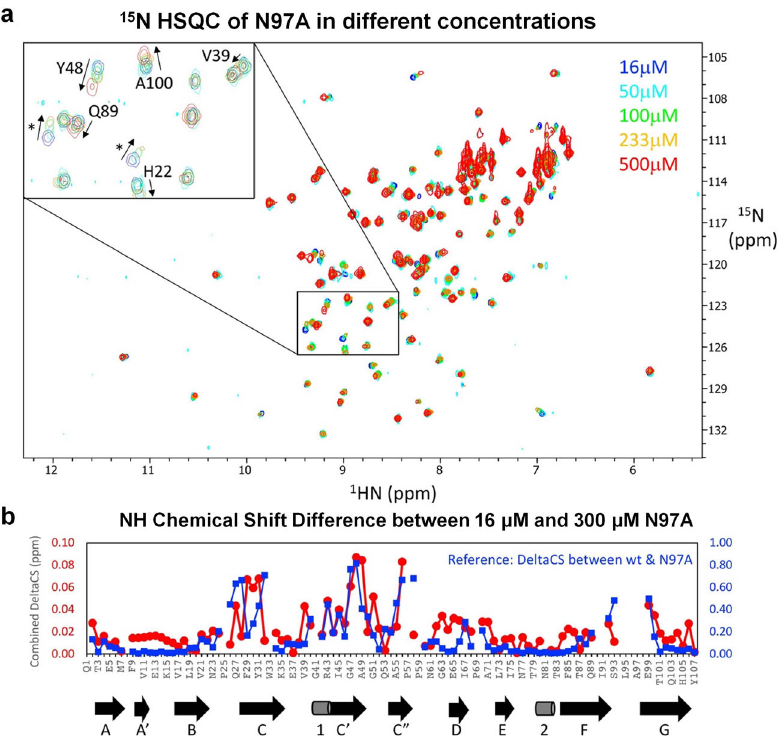
Fig. 7 15 N-HSQC spectra and combined chemical shift changes of N97A mutant at different concentrations. a Overlaid 15 N-HSQC spectra of 16 μ M (blue), 50 μ M (cyan), 100 μ M (green), 233 μ M (orange) and 500 μ M (red) N97A mutant. The inset shows an enlarged view of a central spectral region containing several assigned residues and unassigned residues (marked with “ * ” ). b The relative combined 1 HN and 15 N chemical shift changes of assigned 15 NH peaks between a 16 μ M and a 300 μ M N97A mutant protein sample (red circles), in comparison with the relative combined 1 HN and 15 N chemical shift changes of 15 NH peaks between the WT and N97A mutant proteins (blue squares). The secondary structure elements from the X-ray structure of N97A protein are depicted below for